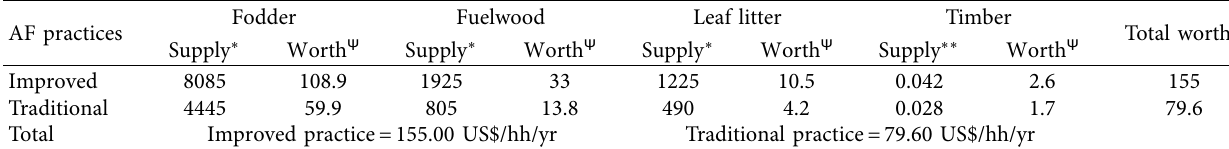
Figure 2: Product-based monetary contribution. Table 3: Monetary valuation of available forest products.